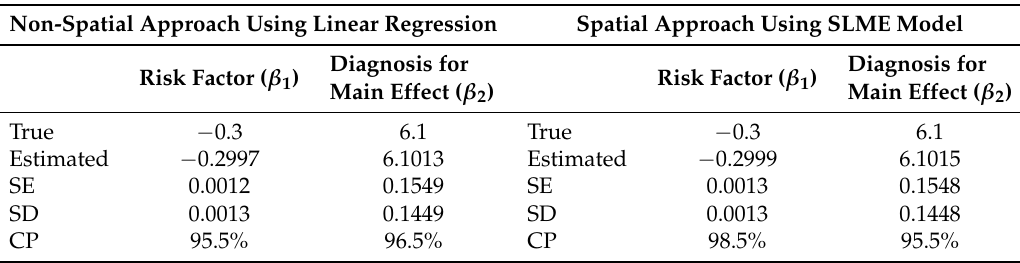
Table 7. Simulation studies: Scenario 1: no correlation between simulated spatial data ( n = 200).